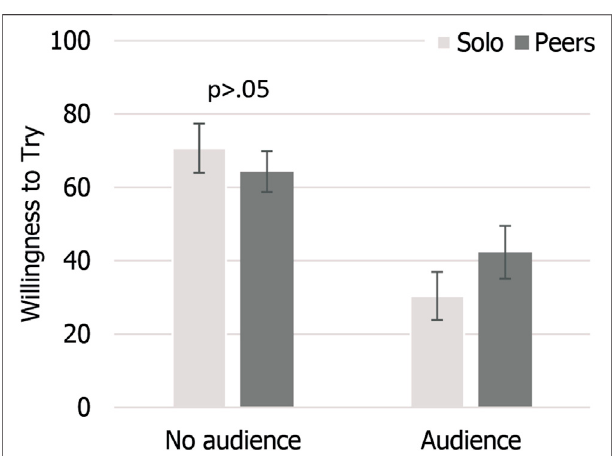
FIGURE6| Asspeci fi edin Figure5 ,exceptwithWillingnesstoTrydata.